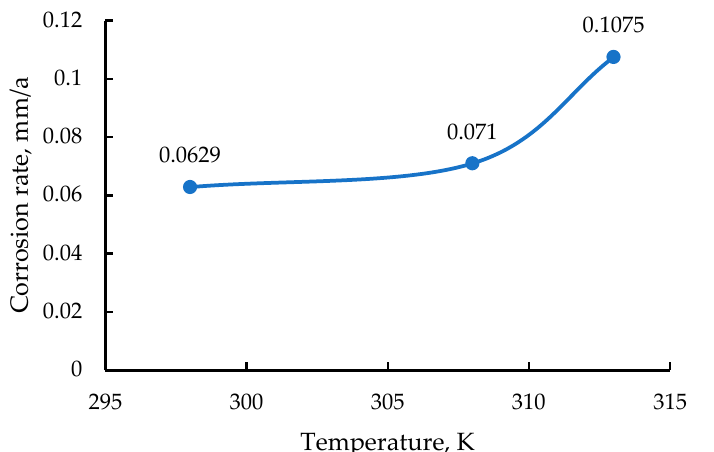
Figure 1. Variation curve of dynamic corrosion rate of 20# steel with temperature and pressure.